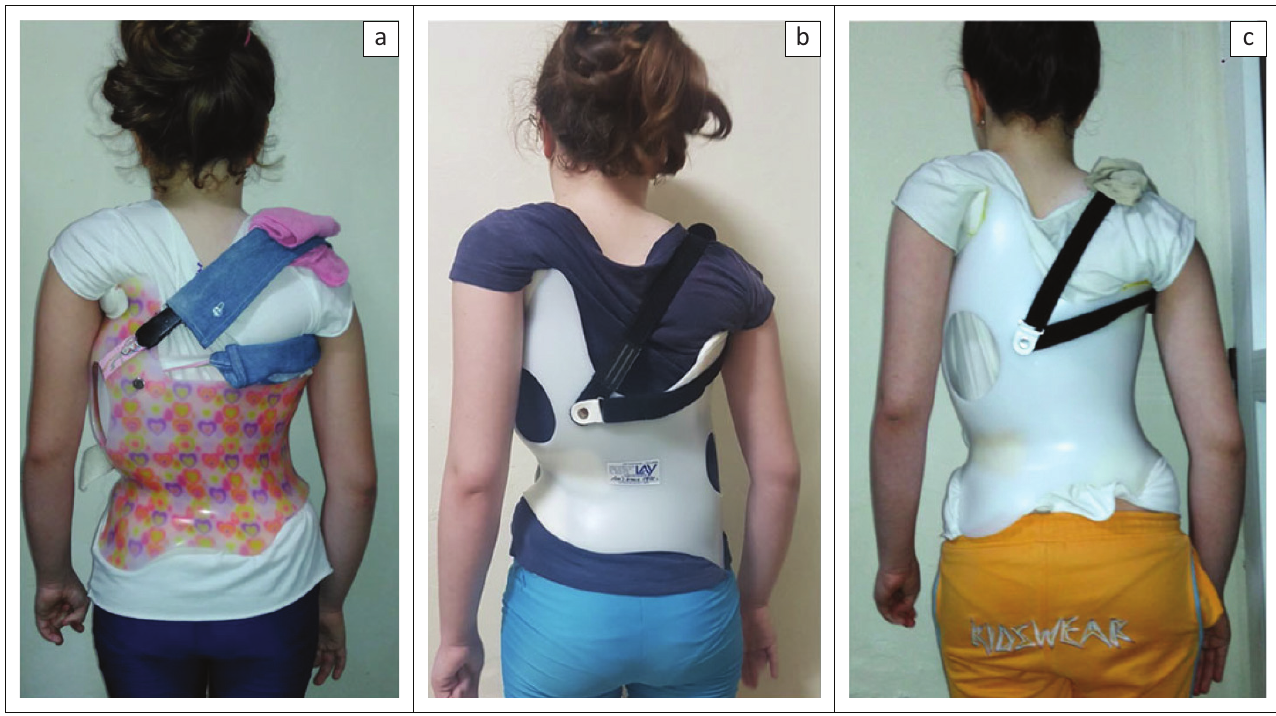
Source : Photos provided by Mario Jimeranez. FIGURE 3: The three braces made for the patient. (a) A Gensingen brace pattern 3C for large curves (11/2019), (b) a Gensingen brace pattern 4C to address the clinical pattern change (9/2020) and (c) third Gensingen brace pattern 3C again